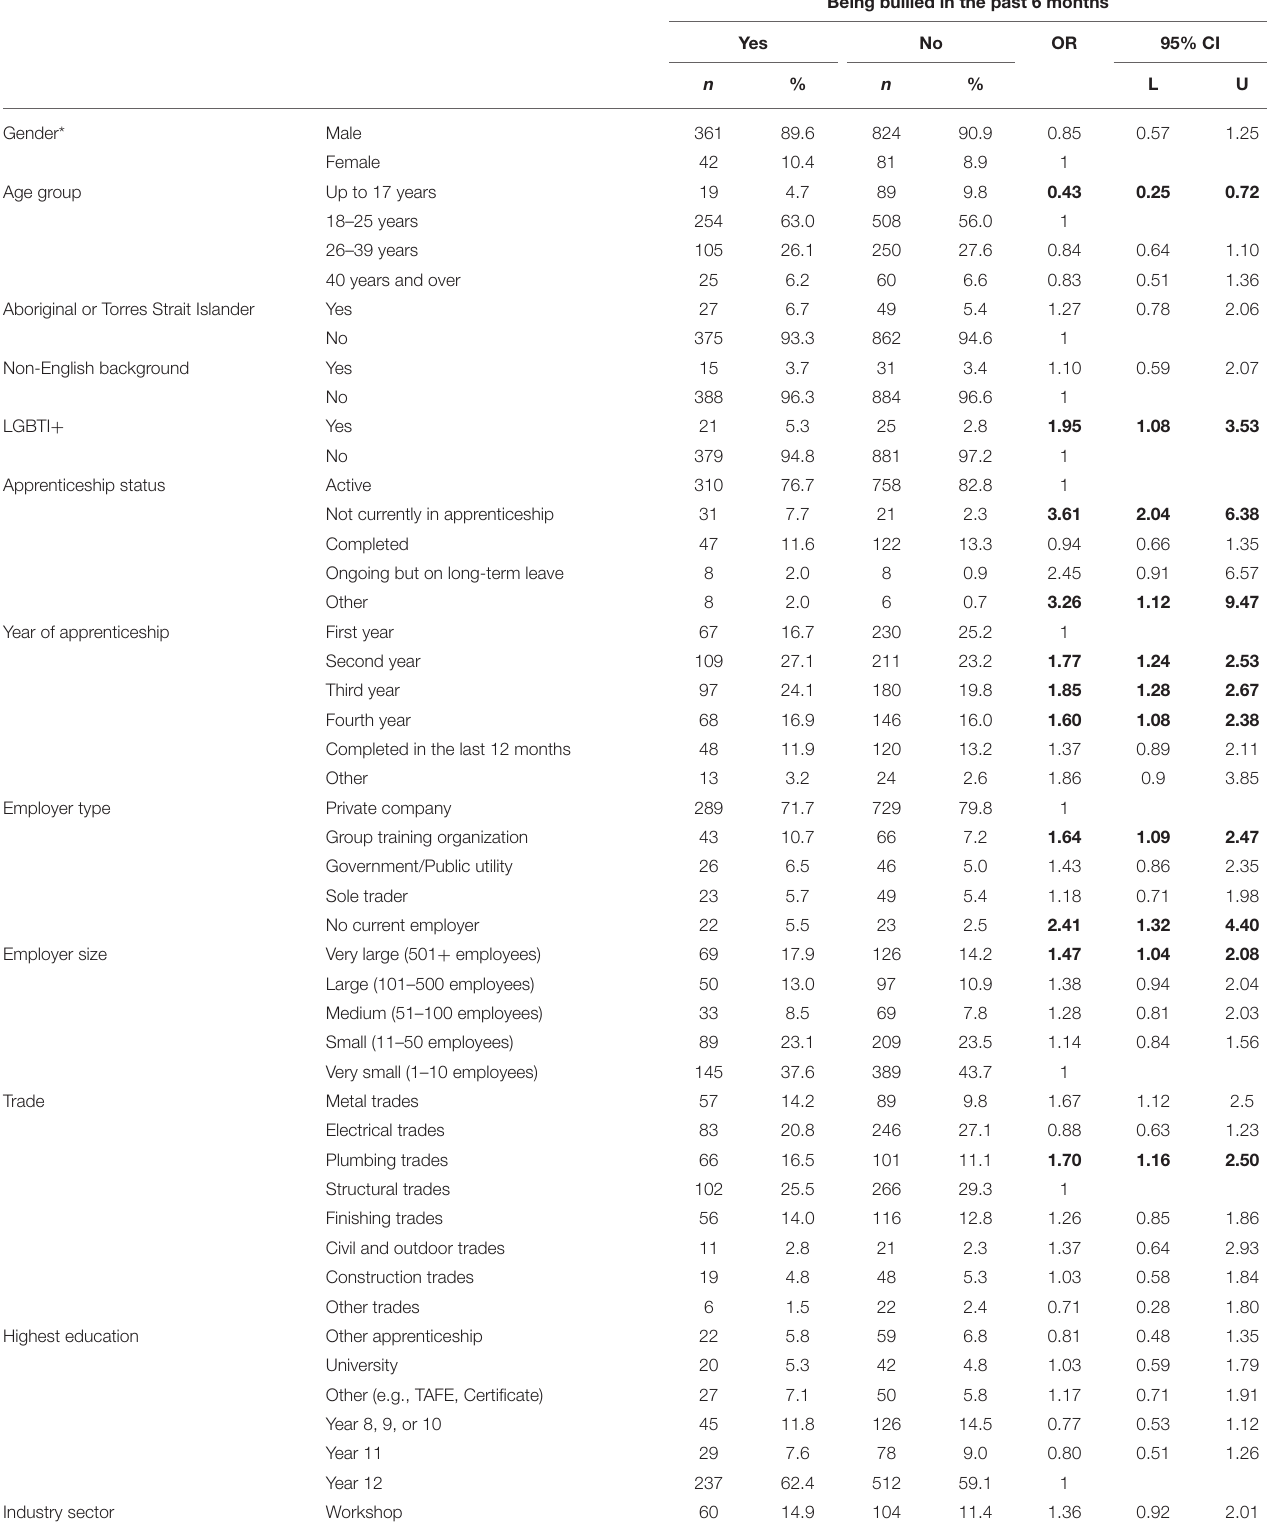
TABLE 2 | Univariate Odds Ratios of subjective bullying in past 6-months by demographic/apprenticeship